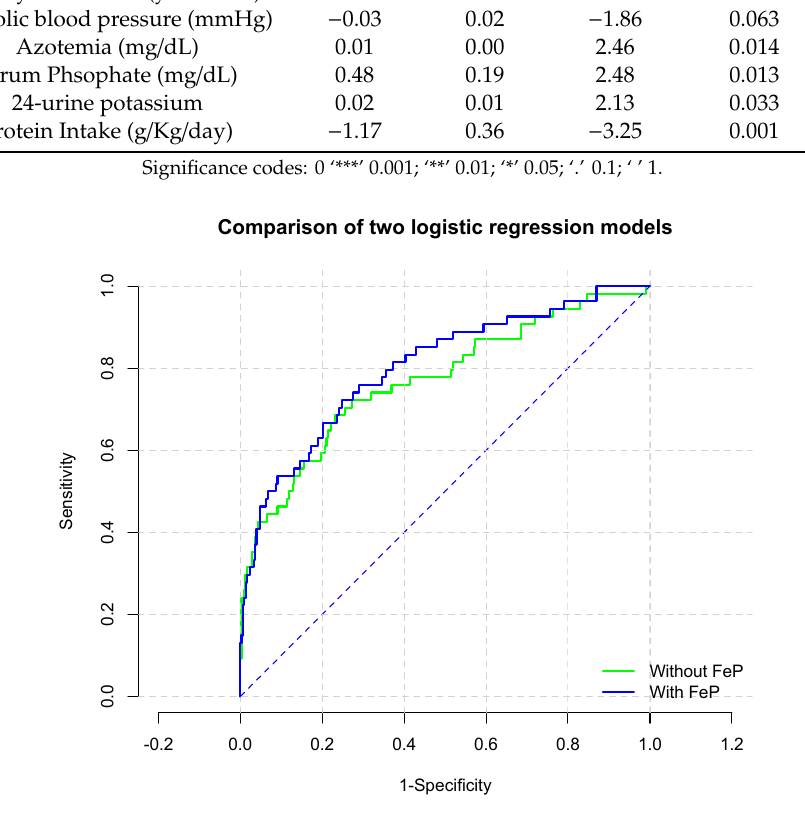
Figure 3. Receiving Operator Curve of the most parsimonious model with and without high- Fractional Excretion of Phosphate (FeP) to predict CKD progression.